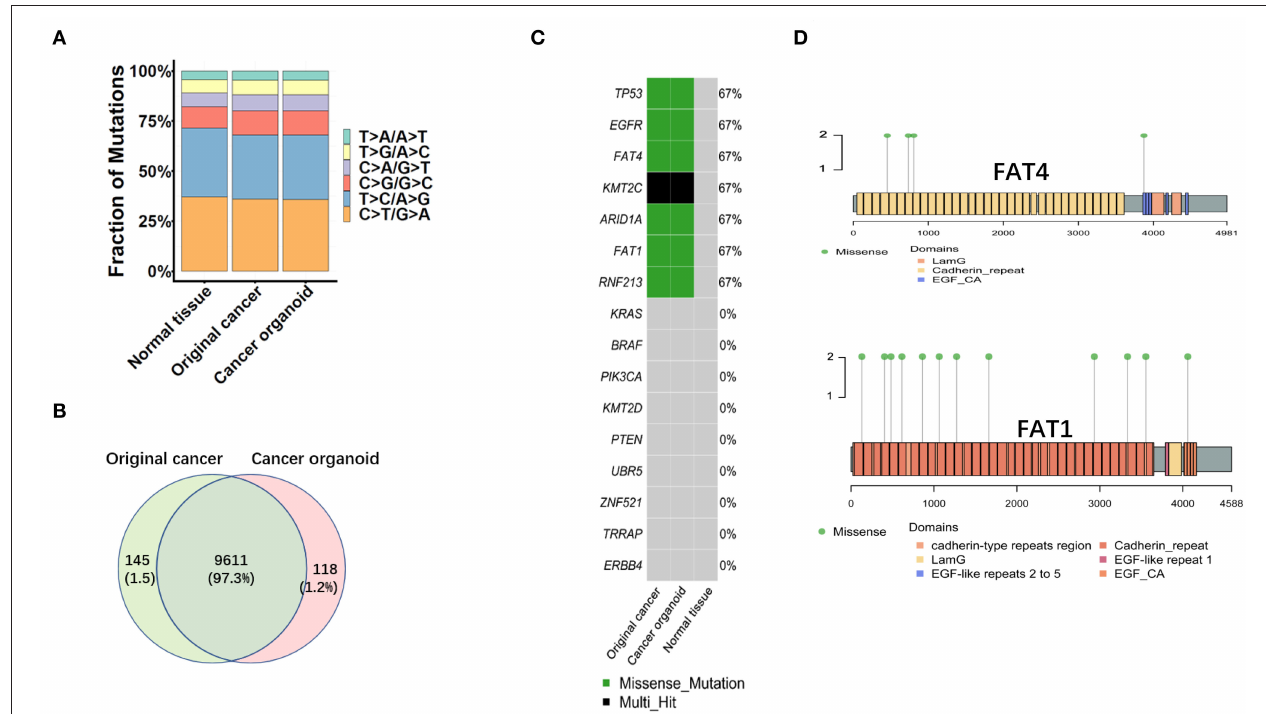
FIGURE 4 | Genetic characterization of MAA. (A) Distribution of base substitutions in the normal, original, and organoid tissue. (B) Venn diagram showing a 97.3% overlap of single nucleotide variants between the original tissue and cancer organoid. (C) Representative gene mutations in the organoid and original tissue. (D) Functionally altered regions of FAT4 and FAT1 genes encoding amino acids of the original tumor and the